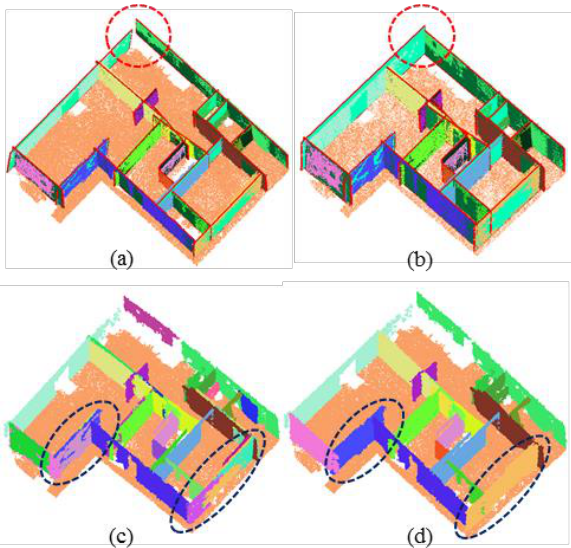
Figure 3: (a) and (b) show before and after the topology correction. Extension of the rectangles for unconnected walls. (c) and (d) show two faces of walls are merged to create volumetric